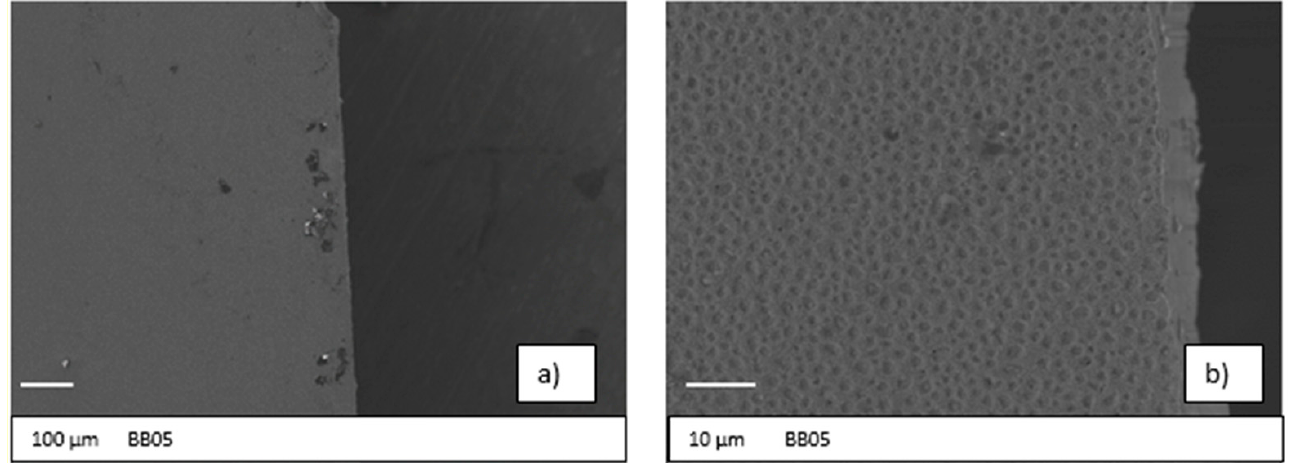
Figure 1. SEM images of the investigated samples. 3.2. Biaxial Flexural Strength Table 2 summarizes the results for the elastic modulus and biaxial flexural strength on the prepared 3YSZ (BB) backbones measured at room temperature using the ball-on- ring method. The elastic modulus was calculated from the load deflection curves given by the ball-on-ring data. In reference [9], the experimental set-up used in the tests is described in detail. Furthermore, a systematic description of the influence of porosity on flexural strength of 3YSZ is also provided. Table 2. Elastic and mechanical properties obtained by the ball-on ring tests of 3YSZ. Samples. Sample